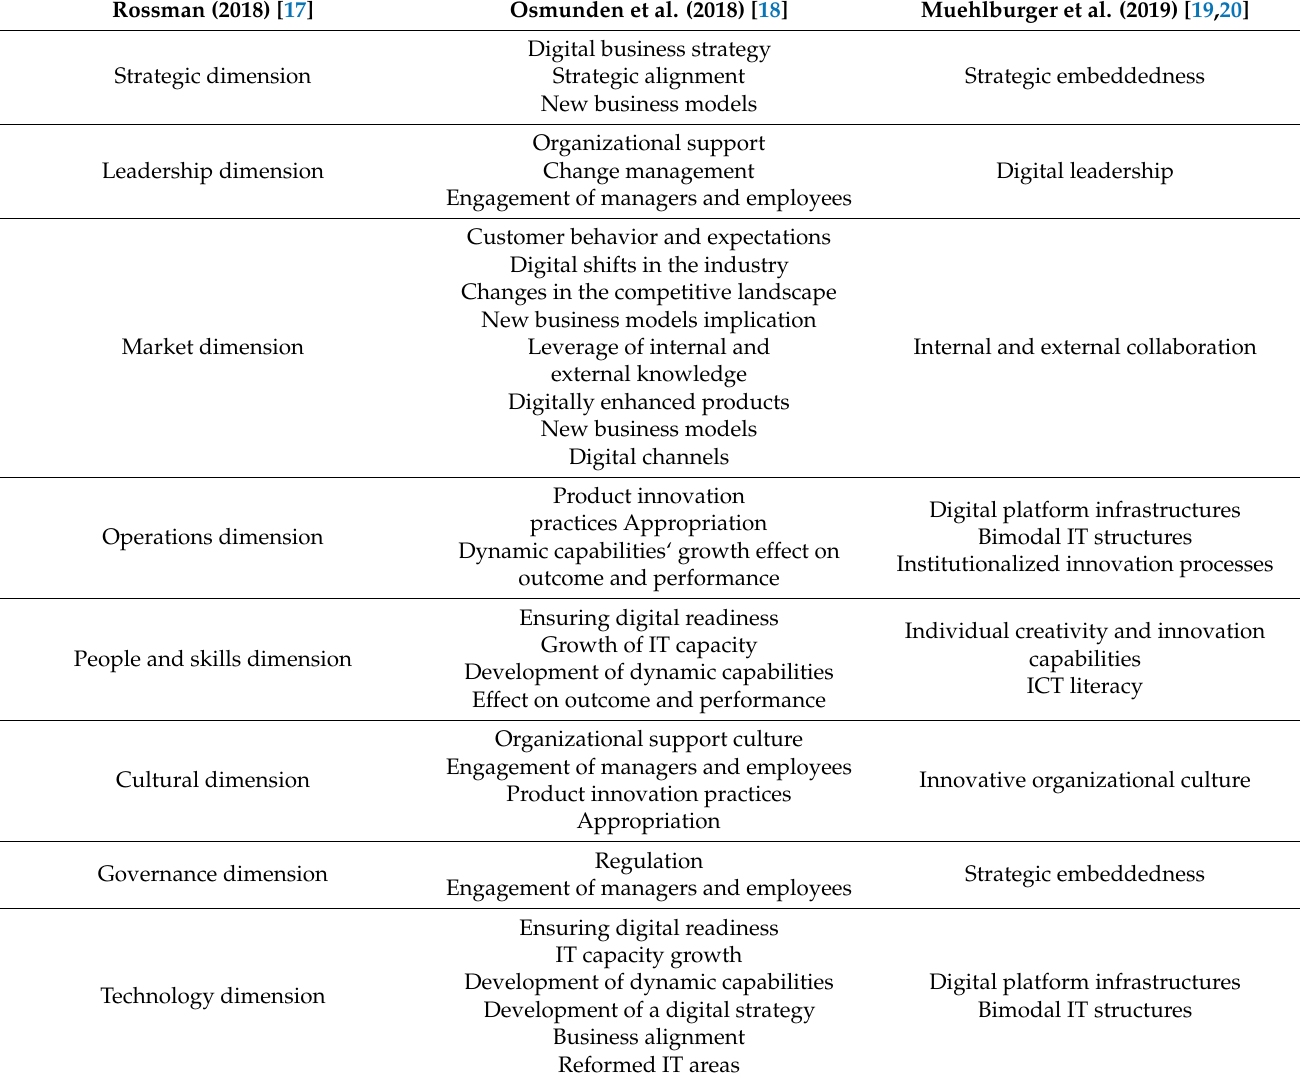
Table 1. Concept mapping from existing